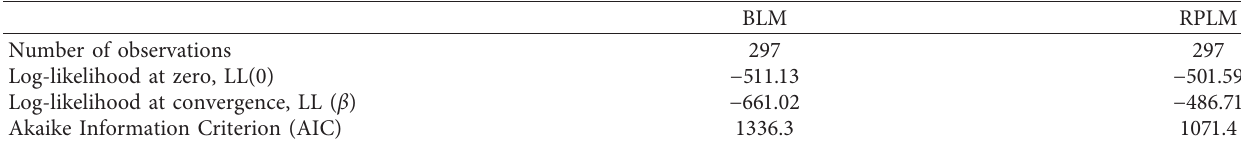
Table 5: Goodness-of-fit measures for BLM and